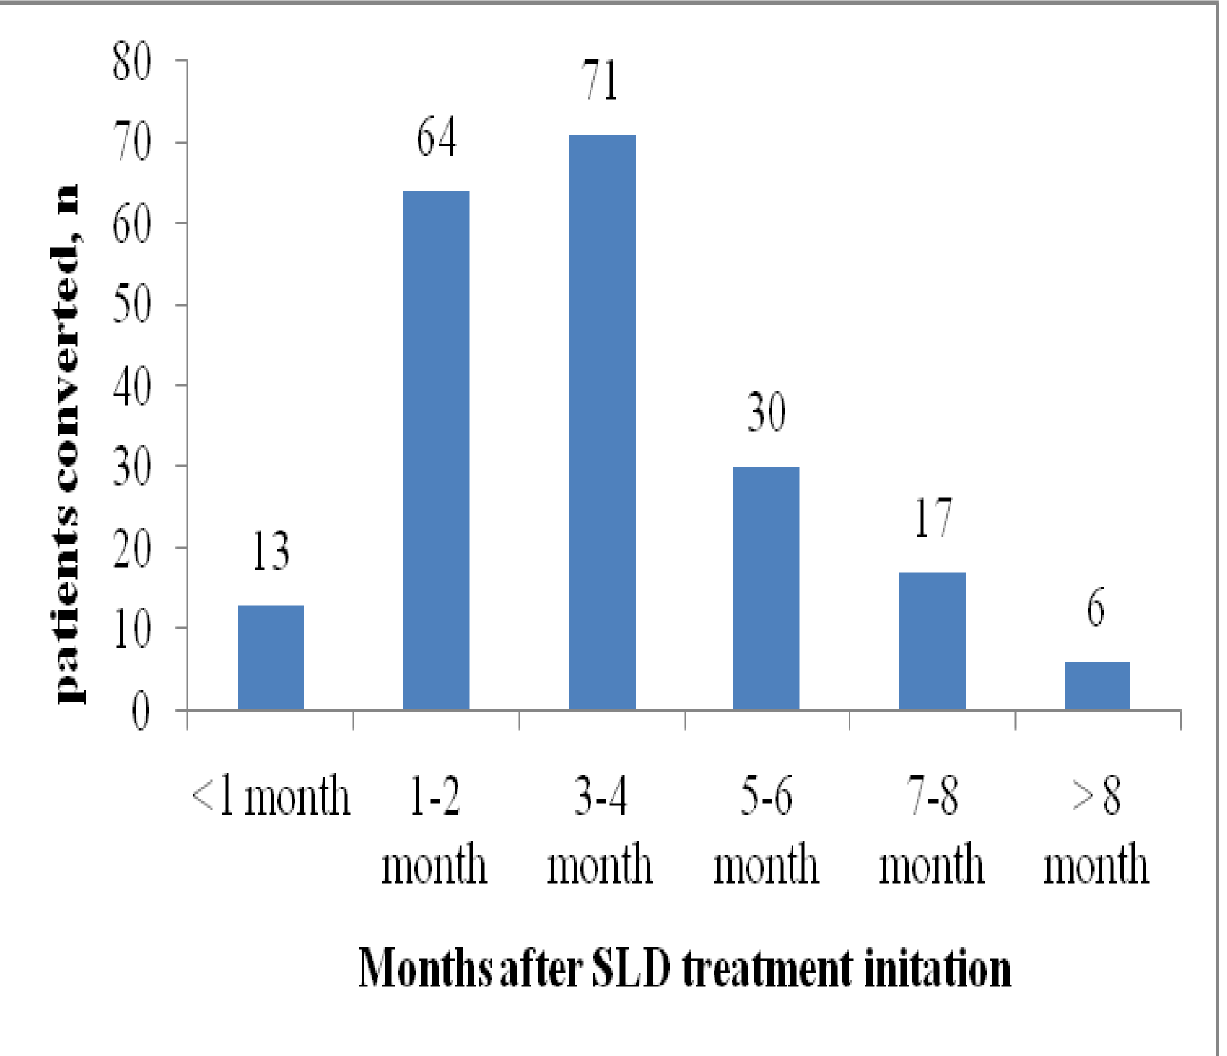
Fig 1. Initial sputum culture conversion in 201 of 235 culture-positive patients who had culture